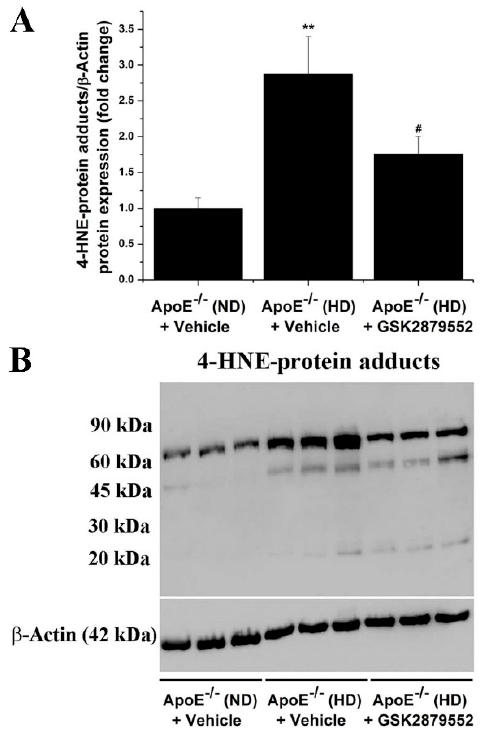
Figure 7. GSK2879552-induced pharmacological inhibition of LSD1 function attenuates the formation of 4-HNE-protein adducts in atherosclerotic ApoE-/- mice. ( A ) Western blot assay-related densitometric analysis showing the reduction of 4-HNE-modified protein levels in the aorta of GSK2879552-treated ApoE-/- (HD) mice. ( B ) Representative immunoblot demonstrating the inhibitory effects of GSK2879552 treatment on 4-HNE-protein adduct accumulation in the aorta of ApoE-/- mice under hypercholesterolemic conditions. n = 3, ** p < 0.01. p -value was taken in relation to vehicle-treated ApoE-/- (ND) condition. # p < 0.05. p -value was taken in relation to vehicle-treated ApoE-/- (HD) condition.